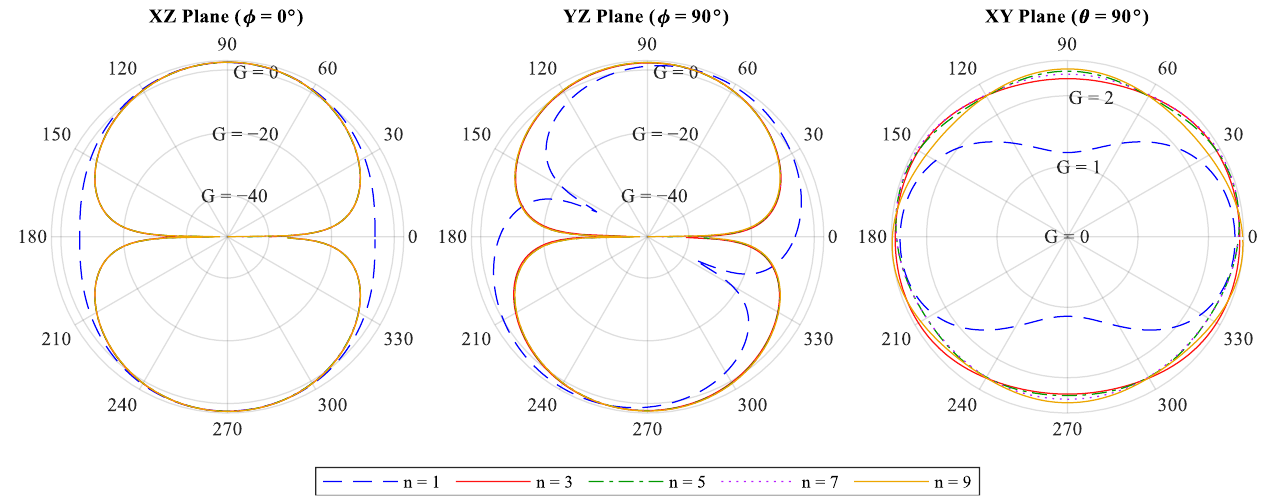
Figure 5. Far-field radiation gain ( 𝐺 ) pattern of the 50 Ω sinusoidal dipole antenna for n = 1,3, … ,9 . The antenna is placed along Z -axis, and the sinusoidal peaks and dips are spread along Y -axis. Table 1. The Maximum Gain and HPBW of the straight half-wave dipole and 50 Ω sinusoidal di- poles for different 𝑛 values.